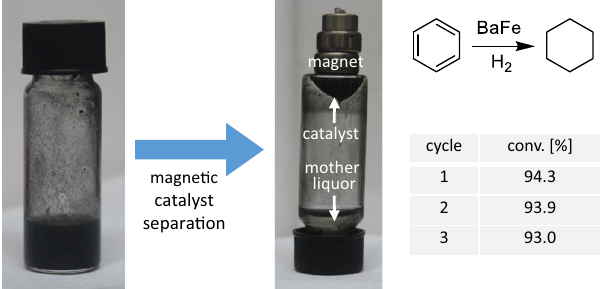
Fig. 4 Catalyst recycling. The BaFe catalyst after benzene-to-cyclohexane hydrogenation (2.5 mol%, 50 bar, 150 °C, 0.5 h) can be separated conveniently with a magnet and